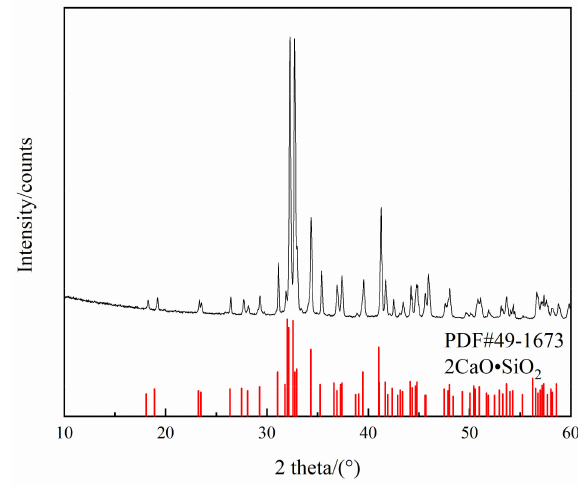
Figure 2. XRD results for C 2 S powder.